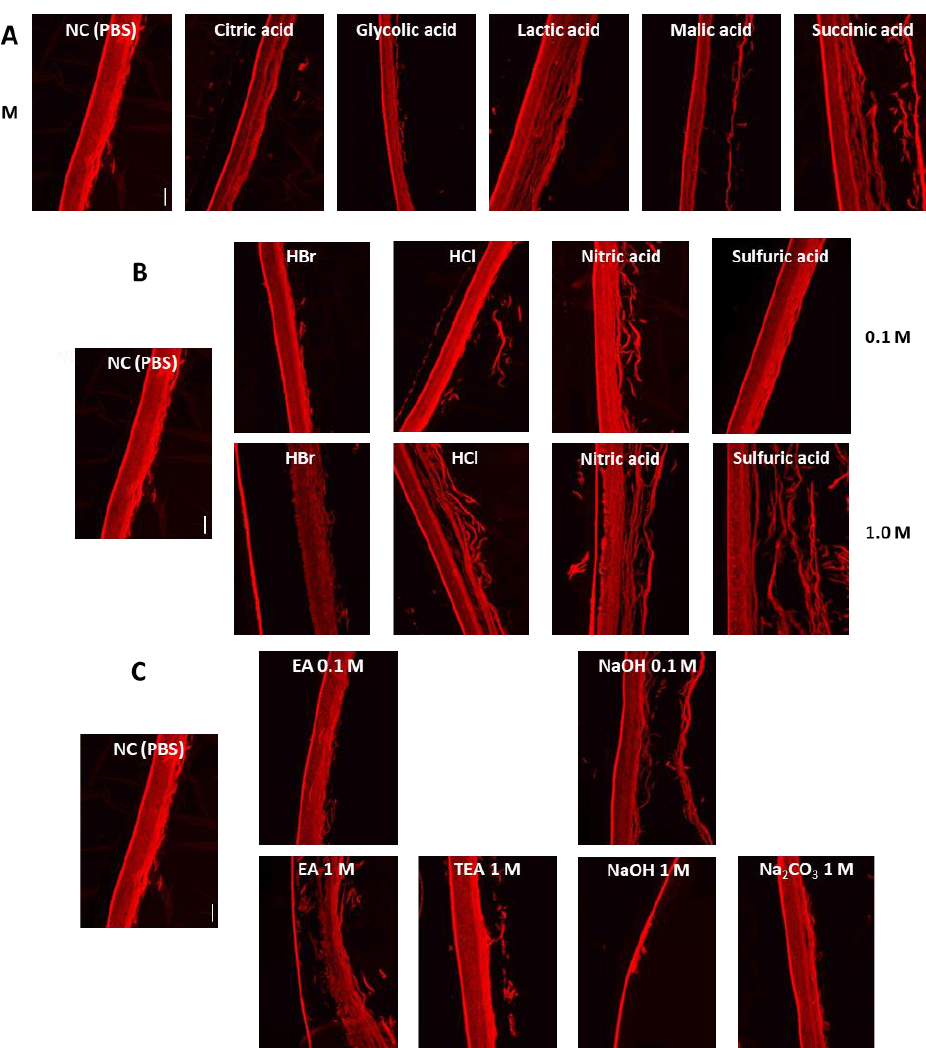
Figure 5. Distribution of lipids in the treated tissues was examined by Nile Red staining. Representative fluorescent microscope image with x magnification. Scale bar is 100 μm. ( A ) Organic acids, ( B ) inorganic acids, and ( C ) organic and inorganic alkalis were treated.